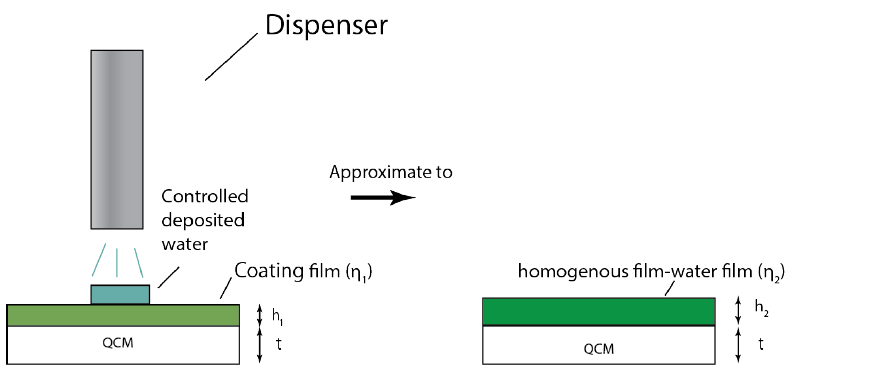
Figure 26. Simplified model of expected film change when exposed to water. Reprinted from [76] under the Creative Commons CC BY 4.0 license.